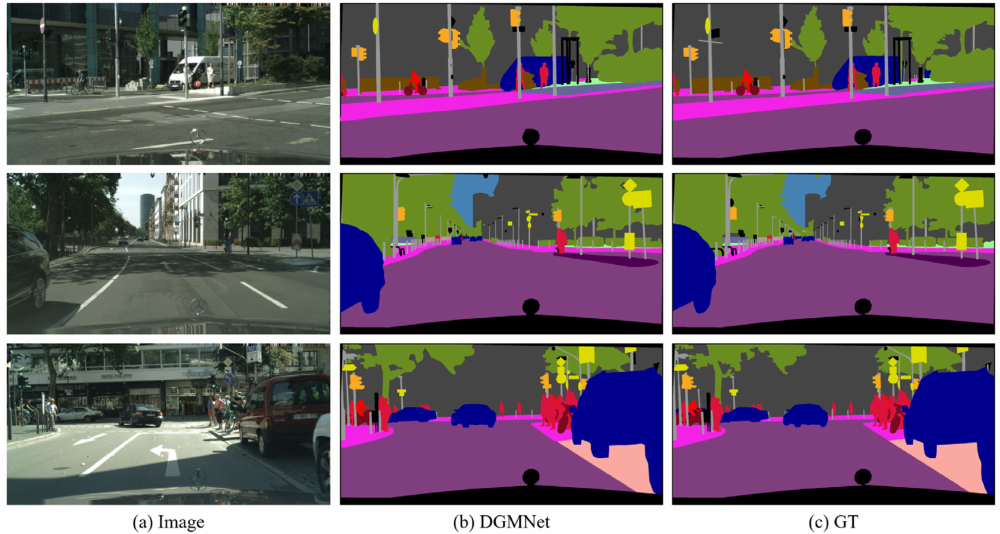
Figure 7. The visualization results of DGMNet on the Cityscapes test dataset.